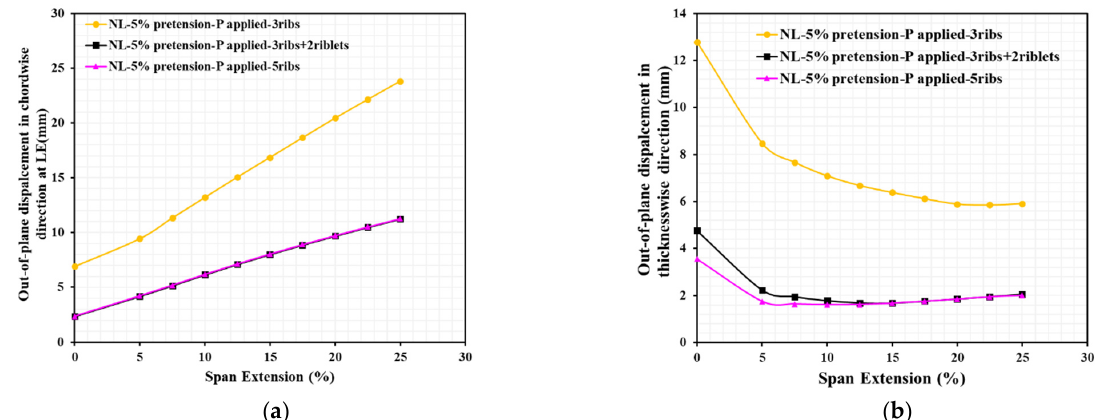
Figure 15. Out-of-plane skin deformation for different models ( a ) Out-of-plane deformation in chordwise direction. ( b ) Out-of-plane deformation in thicknesswise direction.